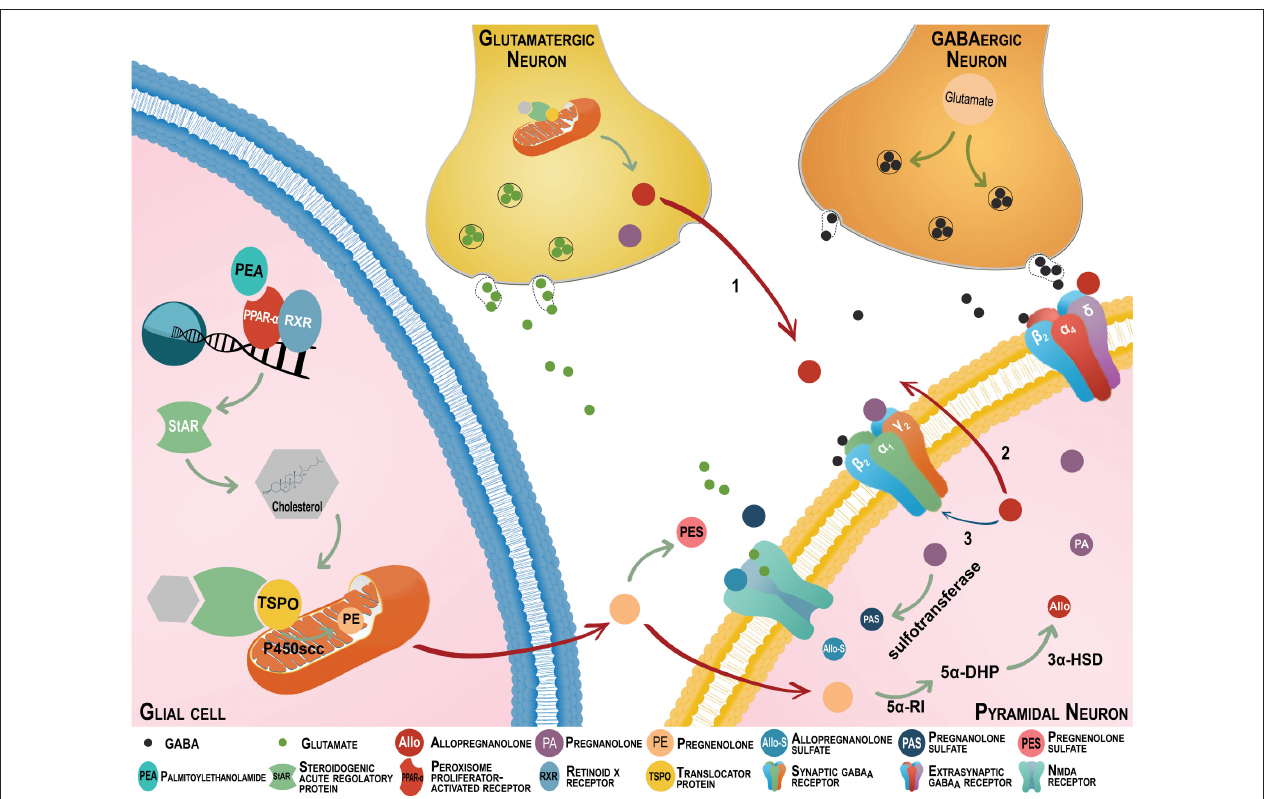
FIGURE 1 | The endocannabinoid and neurosteroid systems cross-talk regulates emotional behavior. The neurosteroids, allopregnanolone (Allo) and its equipotent isomer pregnanolone (PA) are primarily synthesized in glutamatergic corticolimbic neurons and upon secretion; they may act at GABA A receptors located on cell bodies or dendrites of distal pyramidal neurons (Arrow 1). They may also act at GABA A receptors located on glutamatergic neurons’ dendrites or cell bodies by an autocrine mechanism (Arrow 2), or may access and act at the intracellular sites of GABA A receptors located in glutamatergic neurons that produced allopregnanolone itself (Arrow 3) ( Agís-Balboa et al., 2006, 2007; Pinna et al., 2008). Allopregnanolone plays a central neuromodulatory role in facilitating the action of GABA at GABA A receptors (a primary target of anxiolytics) and in the fine-tuning of the receptor for agonists and GABAmimetic agents (Pinna et al., 2000). The finding